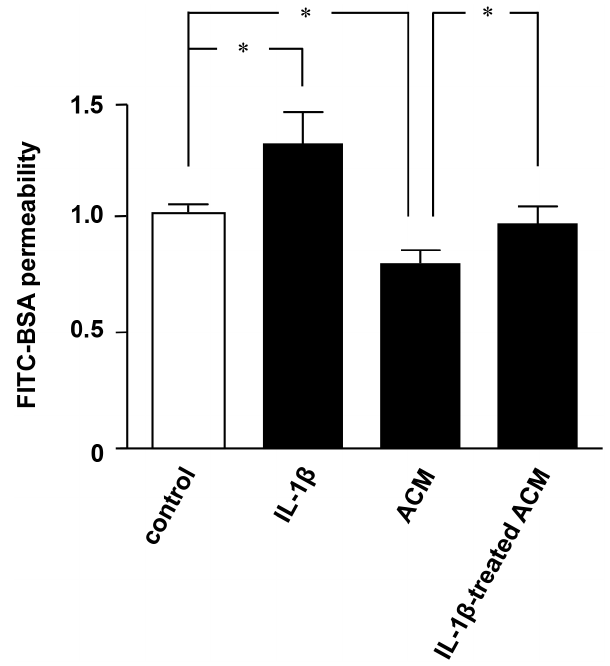
Figure 1. IL-1 b abolishes the protective effect of astrocytes on BBB integrity. MEBC4 cells were treated for 24 h with 2 ng/ml IL-1 b , ACM, or IL-1 b –treated ACM for 24 h. FITC-BSA was loaded onto the luminal side of the insert for 1 h, and then the FITC-BSA levels on the abluminal side were analyzed. All quantitative data are expressed as means 6 SEM (n=5), normalized to the corresponding values from untreated cells. *, p , 0.001.